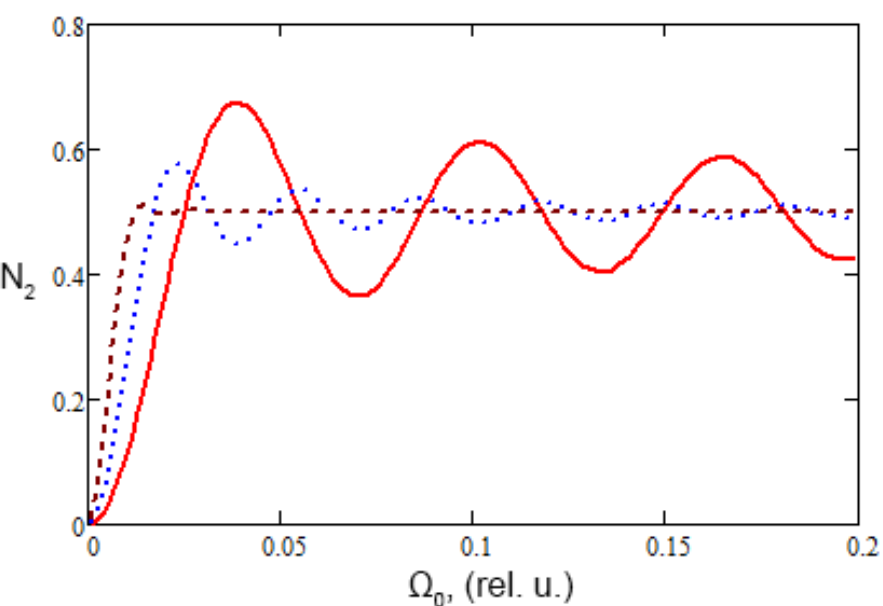
Figure 5. Excited-state population dependence on Rabi frequency for T 2 = 10 2 and ω c = 0.37: solid line— τ = 100, dotted line— τ = 200, dashed line— τ = 500.